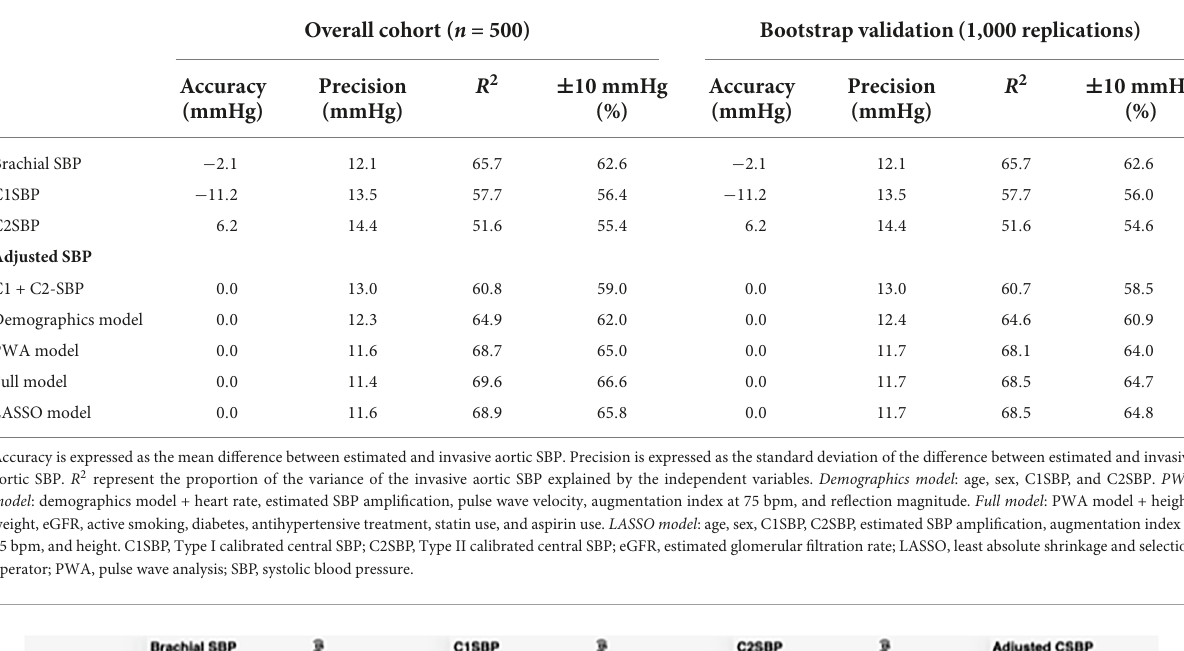
TABLE 3 Prediction of invasive aortic SBP by estimated central SBP and clinical parameters.